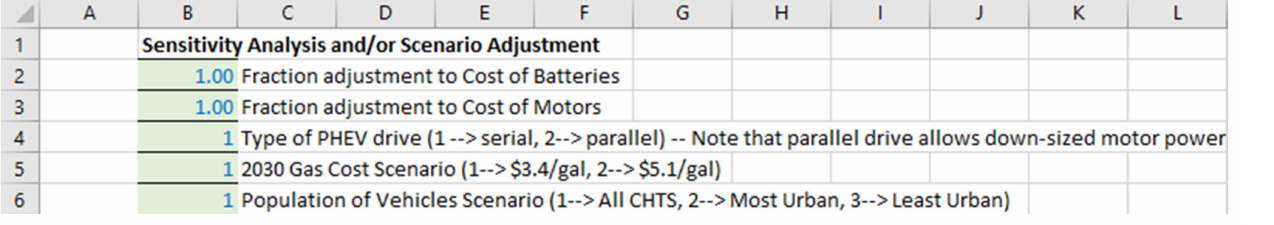
Figure 2. Excerpt from the spreadsheet in [14] showing spreadsheet cells controlling sensitivity